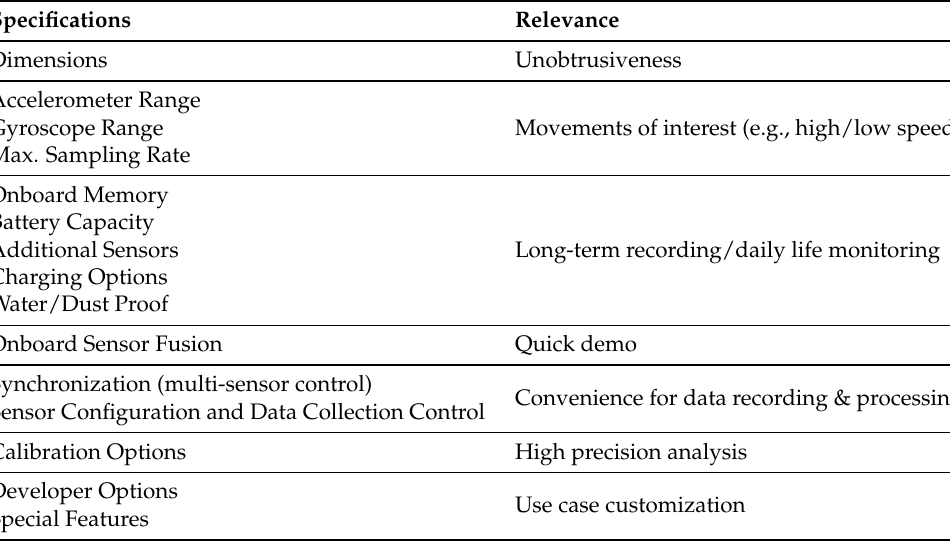
Figure 2. Overview of the proposed guideline for inertial measurement unit (IMU) selection. Table 1. Recommended specifications for filtering the IMUs of